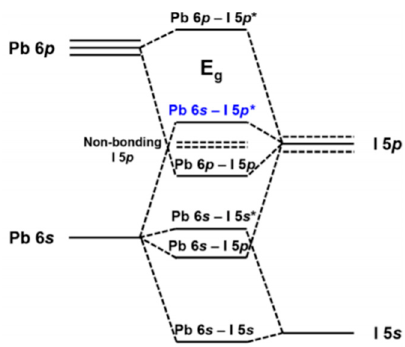
Figure 14. Band gap of MAPbI 3 . The orbital contributions of Pb and I. Reproduced with permission from Chem. Mater. 2016 , 28 , 4259–4266. Reference